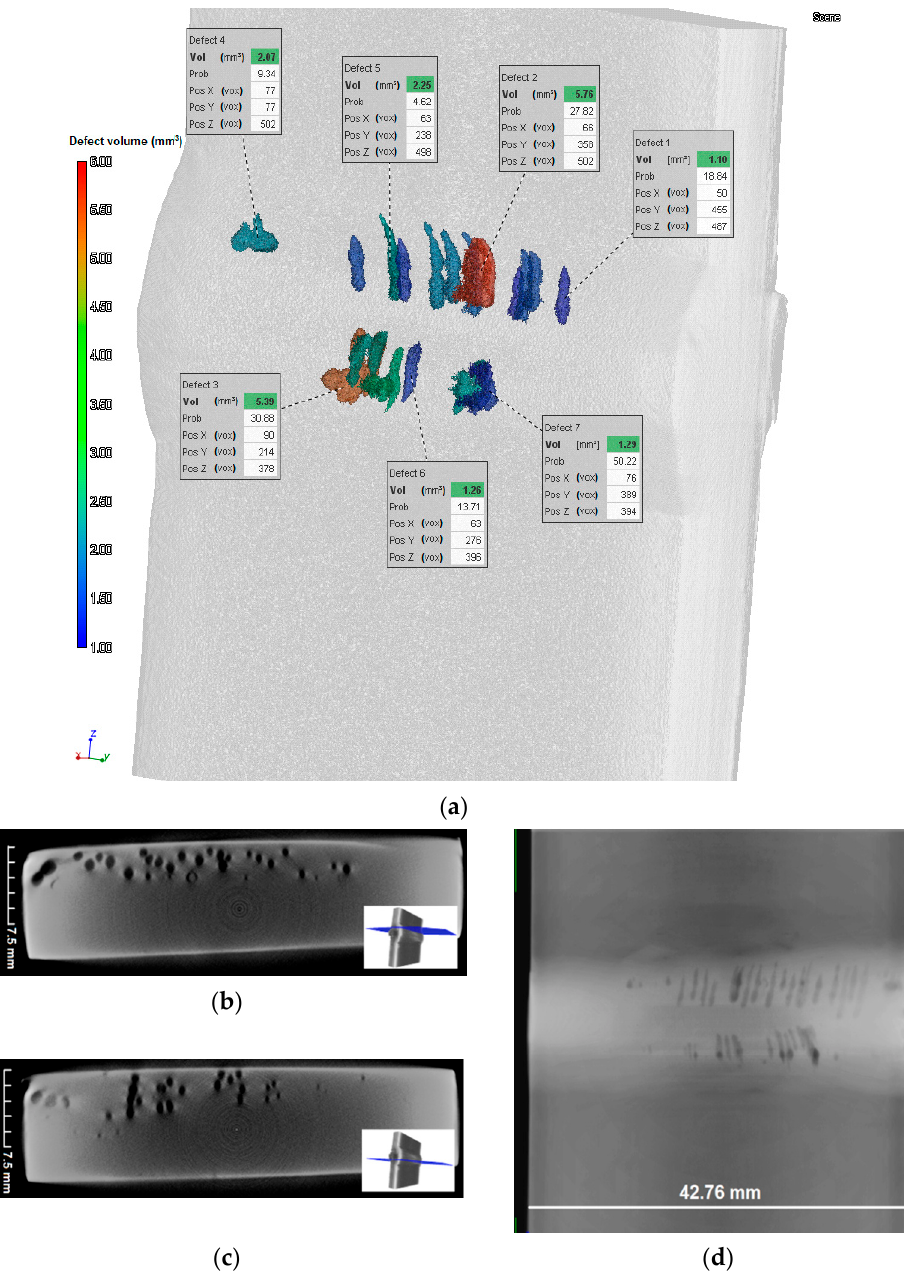
Figure 4. CT results for specimen 991-FM-2 (type-NC-4): ( a ) defect evaluation; ( b , c ) tomograms of the cross-section of the weld bead and ( d ) some along X-rays of the joint.